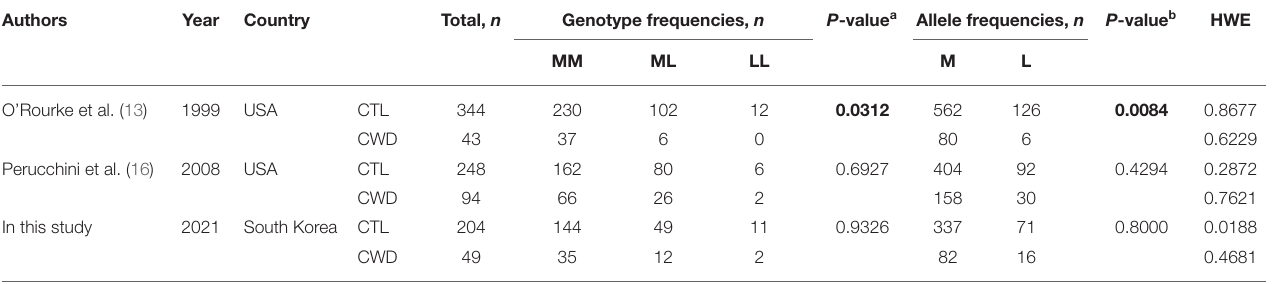
TABLE 1 | Comparison of genotype and allele frequencies of the M132L single nucleotide polymorphism (SNP) in the prion protein gene ( PRNP ) between chronic wasting disease (CWD)-affected elks and matched healthy elks.